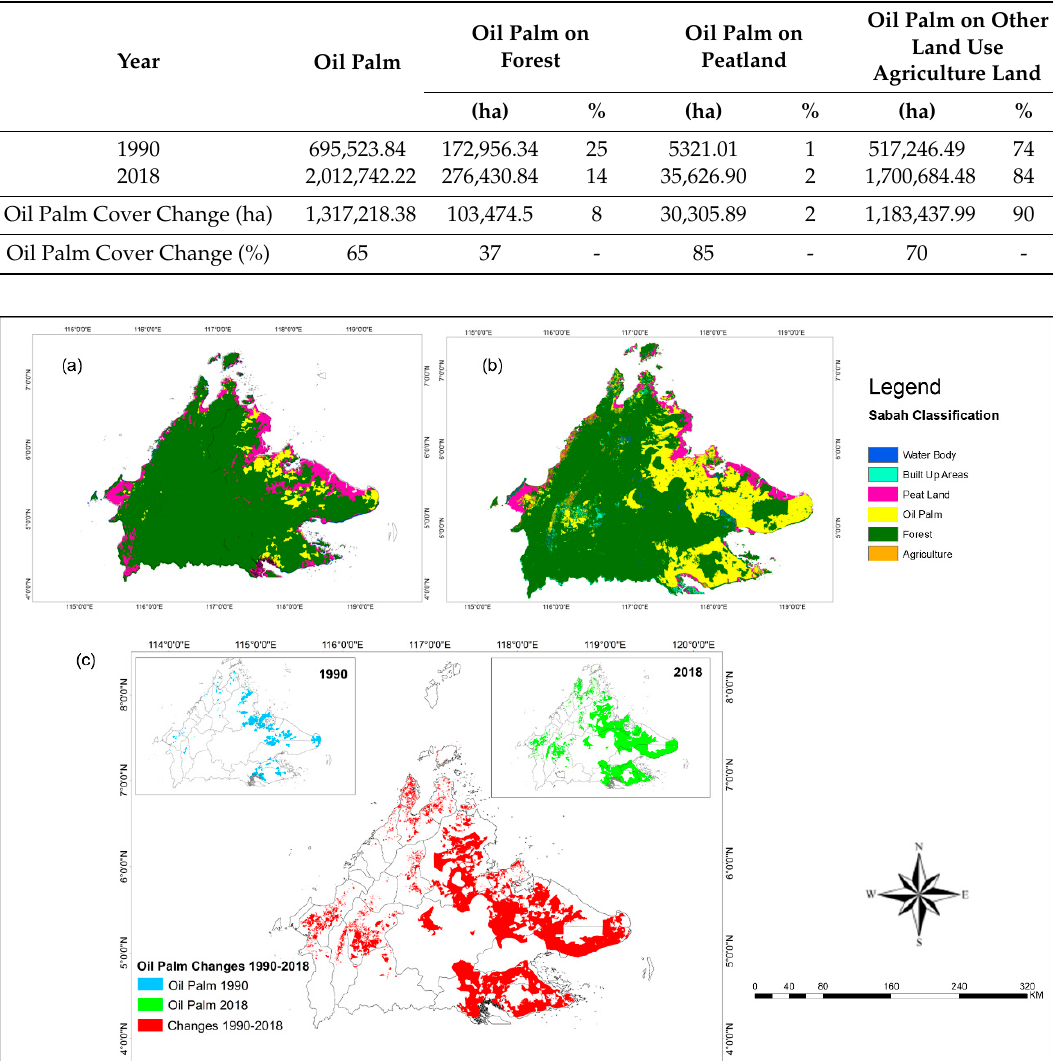
Table 8. Amount of oil palm cover in Sabah (1990 and 2018).